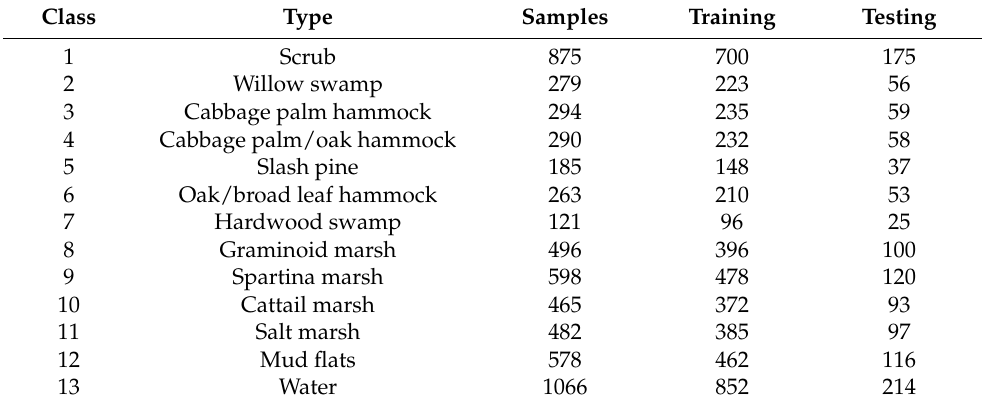
Table 2. Classes and number of test and training samples for Kennedy Space Center (KSC) dataset (corresponding to Five-Fold cross-validation